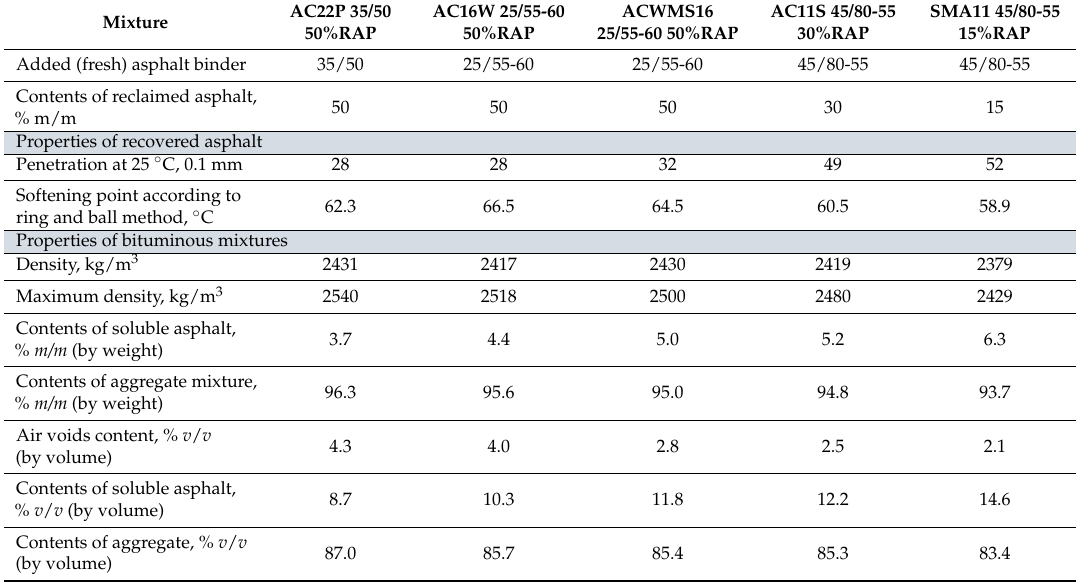
Table 1. Properties of recovered binders and bituminous mixtures with reclaimed